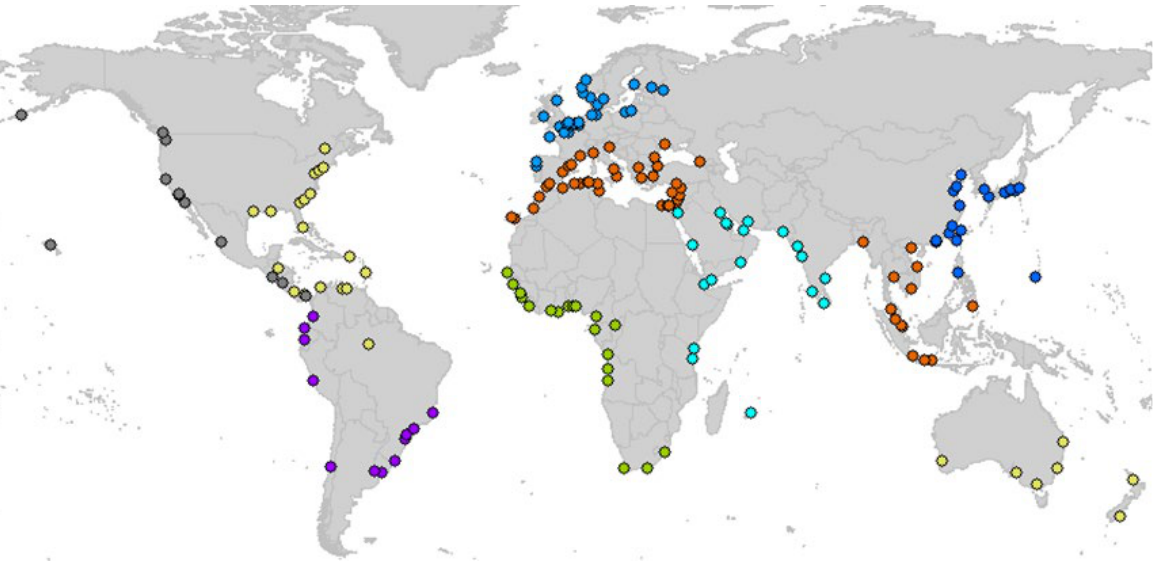
Figure 3. Ten communities in the global shipping network.